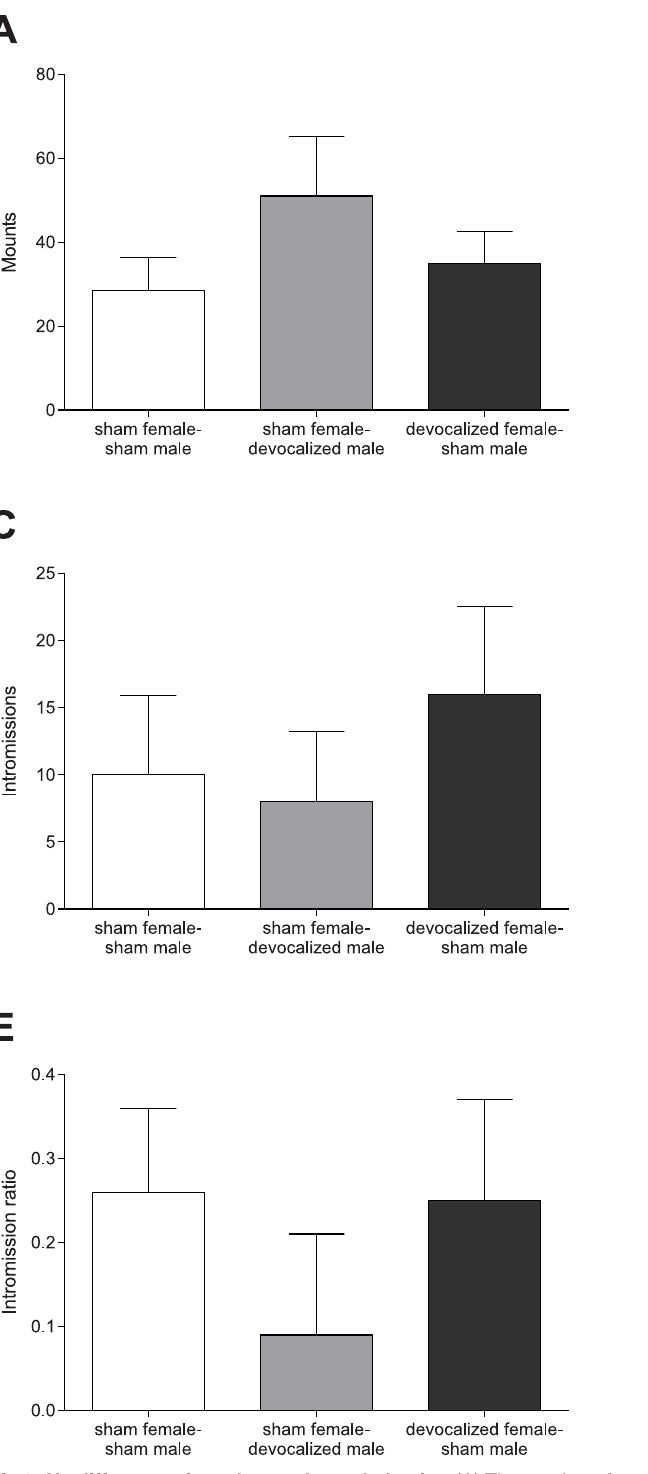
PLOS ONE | DOI:10.1371/journal.pone.0144164 December 3,